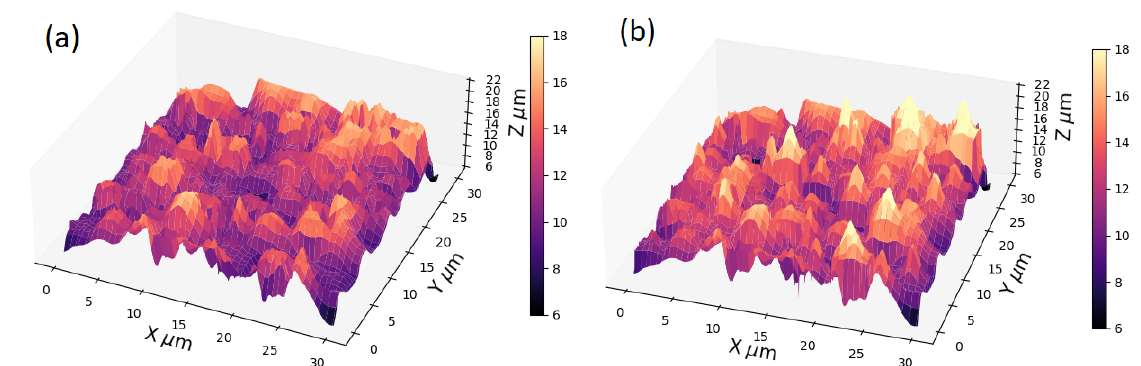
Figure 6. Three-dimensional surface for the elastomer-magnetic particle system for test 1 with RMS height of 2 µ m, τ x = 2 µ m, and τ y = 2 µ m ( a ) Initial surface without modification. ( b ) Surface modified by the movement of the particles.